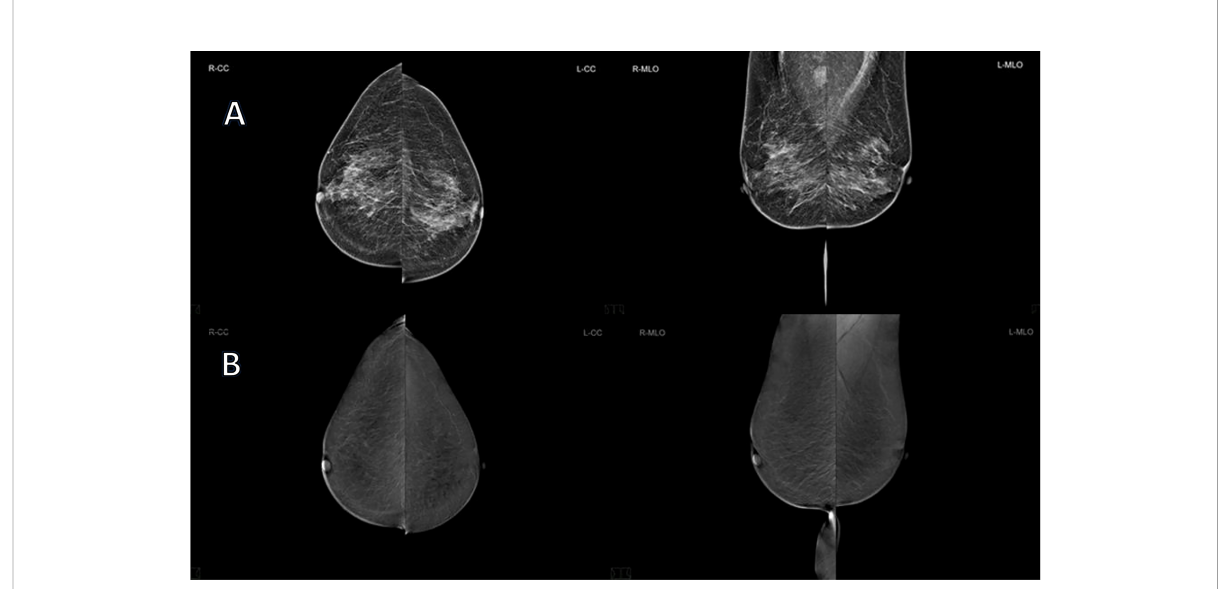
FIGURE 6 65 years old patient, with ACR type B breast density, recalled from screening due to the suspicious mass visible on RMLO in FFDM, classi fi ed as BIRADS 0 (A) and CEM (B) revealed no pathological enhancement. However, US was performed and it detected axillary lymph nodes with a typical metastatic appearance. One of them was biopsied and the pathology report revealed lymph node metastases of invasive lobular carcinoma. Breast MRI and PET-CT examinations were performed as well and they showed no signs of the primary tumor. The patient underwent neoadjuvant hormonal therapy and right mastectomy with axillary lymph node dissection. The fi nal pathology report revealed multicentric invasive lobular carcinoma (grade 2) of the right breast with metastases to 23 out of 28 axillary lymph